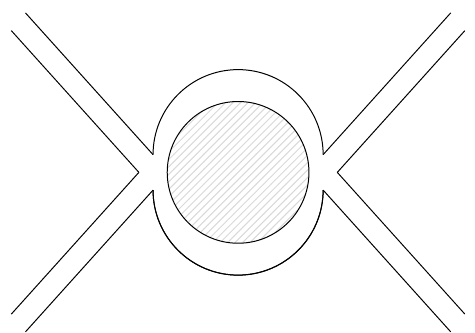
Figure 20. Planar connected diagram contributing to renormalization of a single trace vertex.